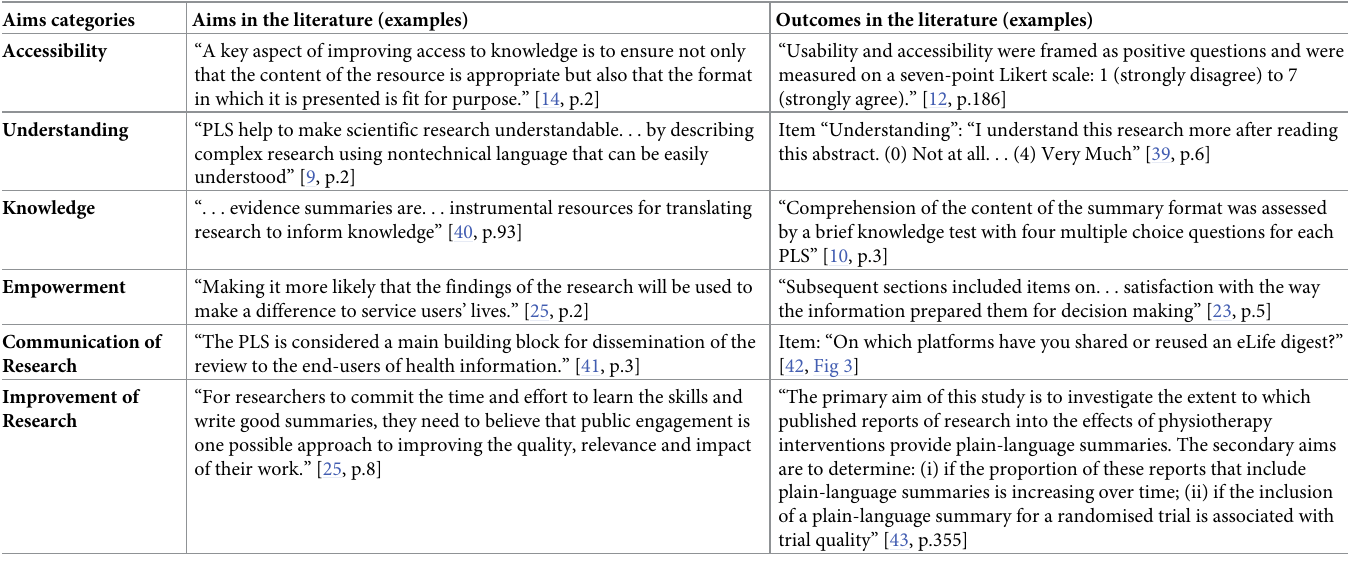
Table 1. Aims categories with matched exemplary text passages of aims and